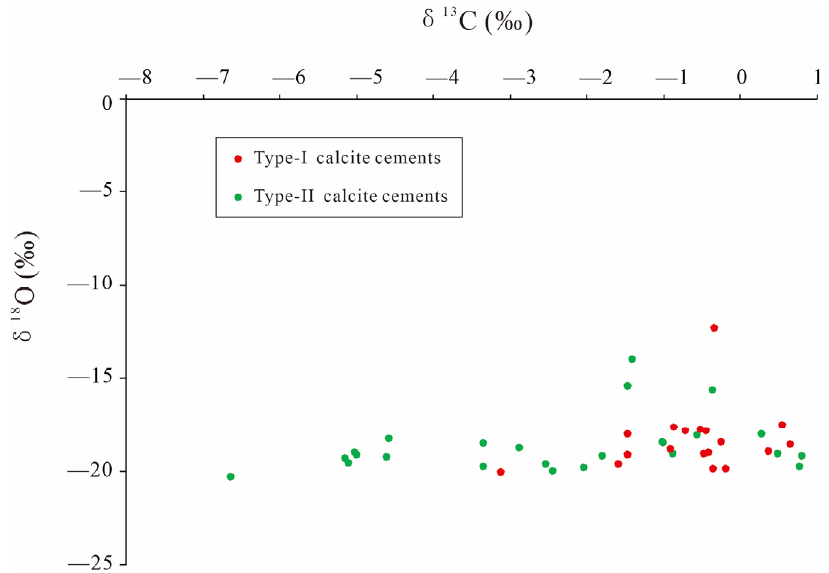
Figure 15. The δ 13 C and δ 13 O values of different types of calcite cements in study area.